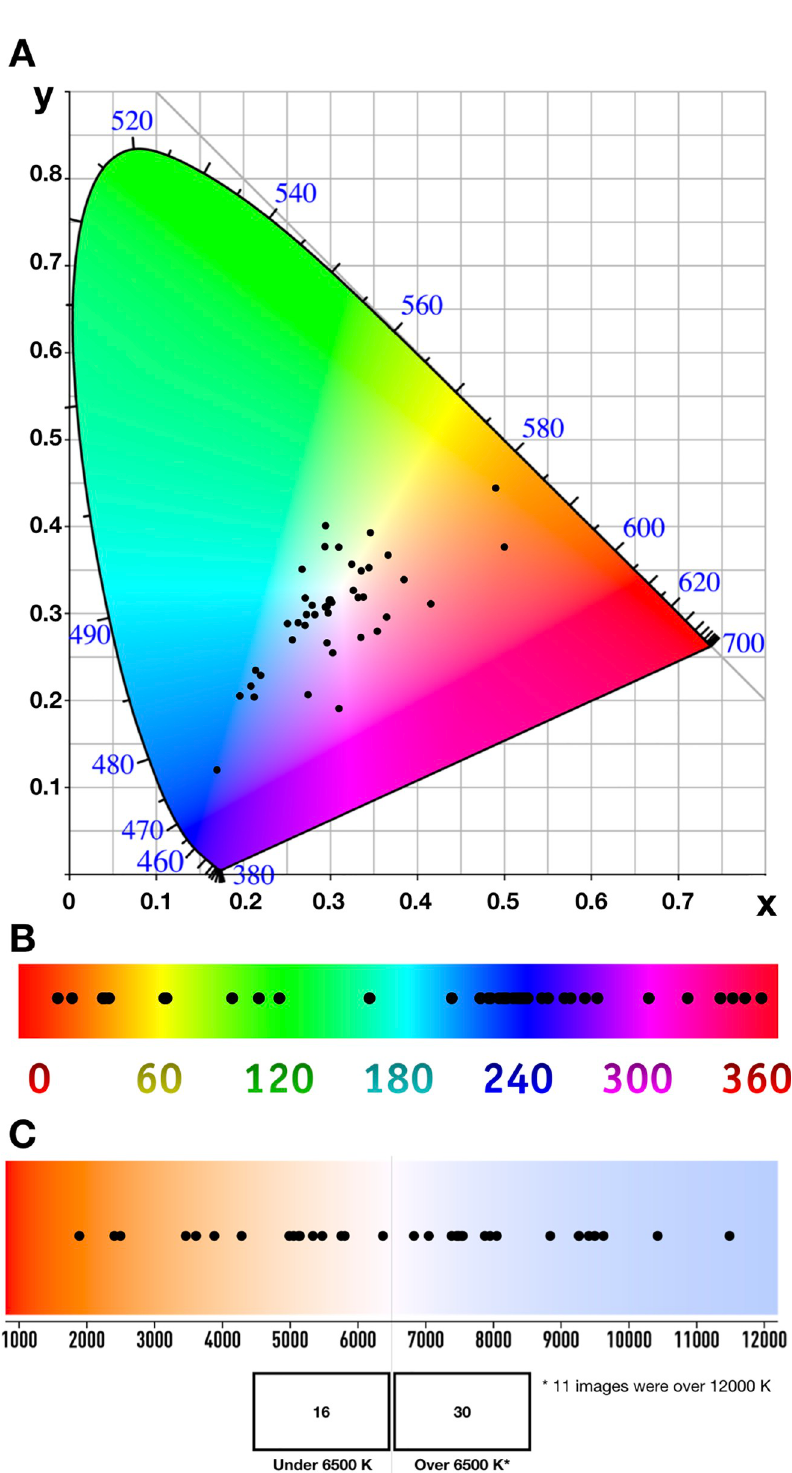
Fig 5. Chromaticity of the coronavirus images. Presentation of the colour parameters for each coronavirus image analysed in the different charts. In all cases, the colours shown are only a pedagogic reference approximation: A, CIE 1931 Chromaticity chart, the numbers in blue are in nanometres; B, Hue 360˚ Chromaticity chart with the numbers in degrees; C, Kelvin chart with the numbers are in Kelvin.